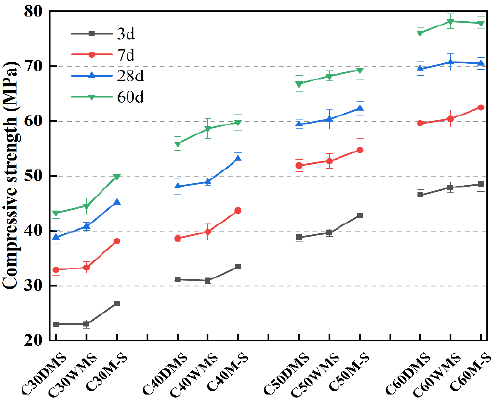
Figure 10. Comparison of compressive strengths of concrete in each group at different ages.